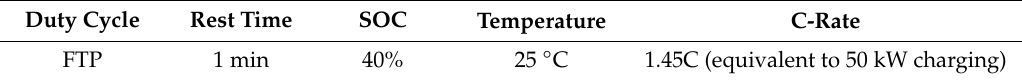
Table 2. Test conditions for measuring the training data.